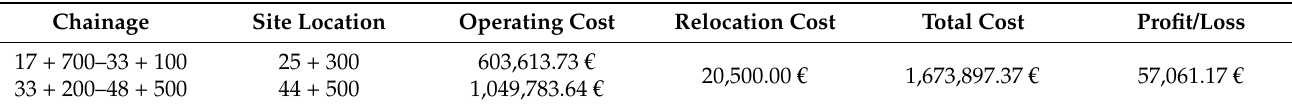
Table 11. Profit gained by splitting the project into two